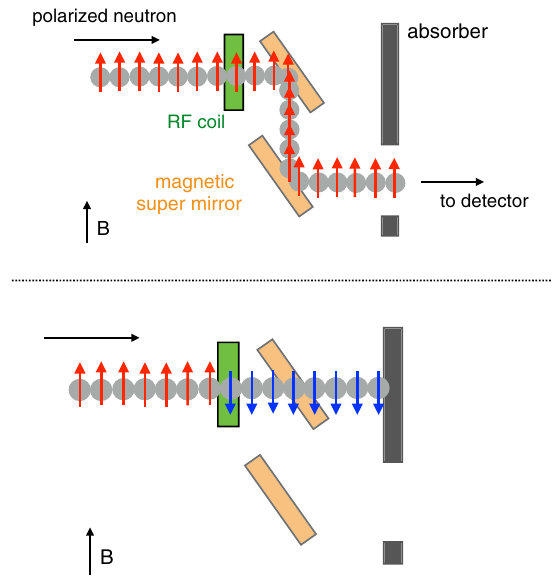
Figure 2. Principle of the SFC operation. The neutron beam passes through the SFC when no current is applied at the RF coil (Top), and is absorbed when RF current is applied